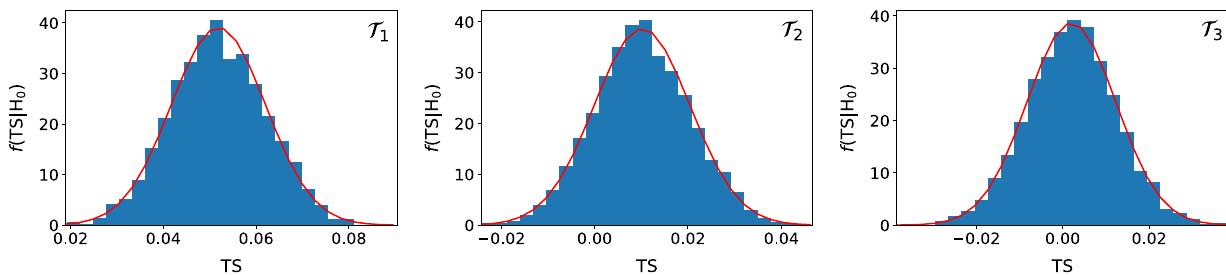
Fig. 4 Distribution of the test statistic under the null hypothesis for our 3 signal points. Overlayed is a Gaussian distribution with the same mean and standard deviation as the data